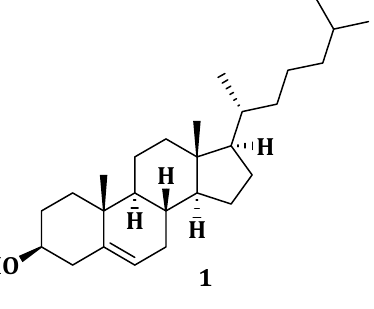
Figure 1. Structure of cholesterol ( 1 ).